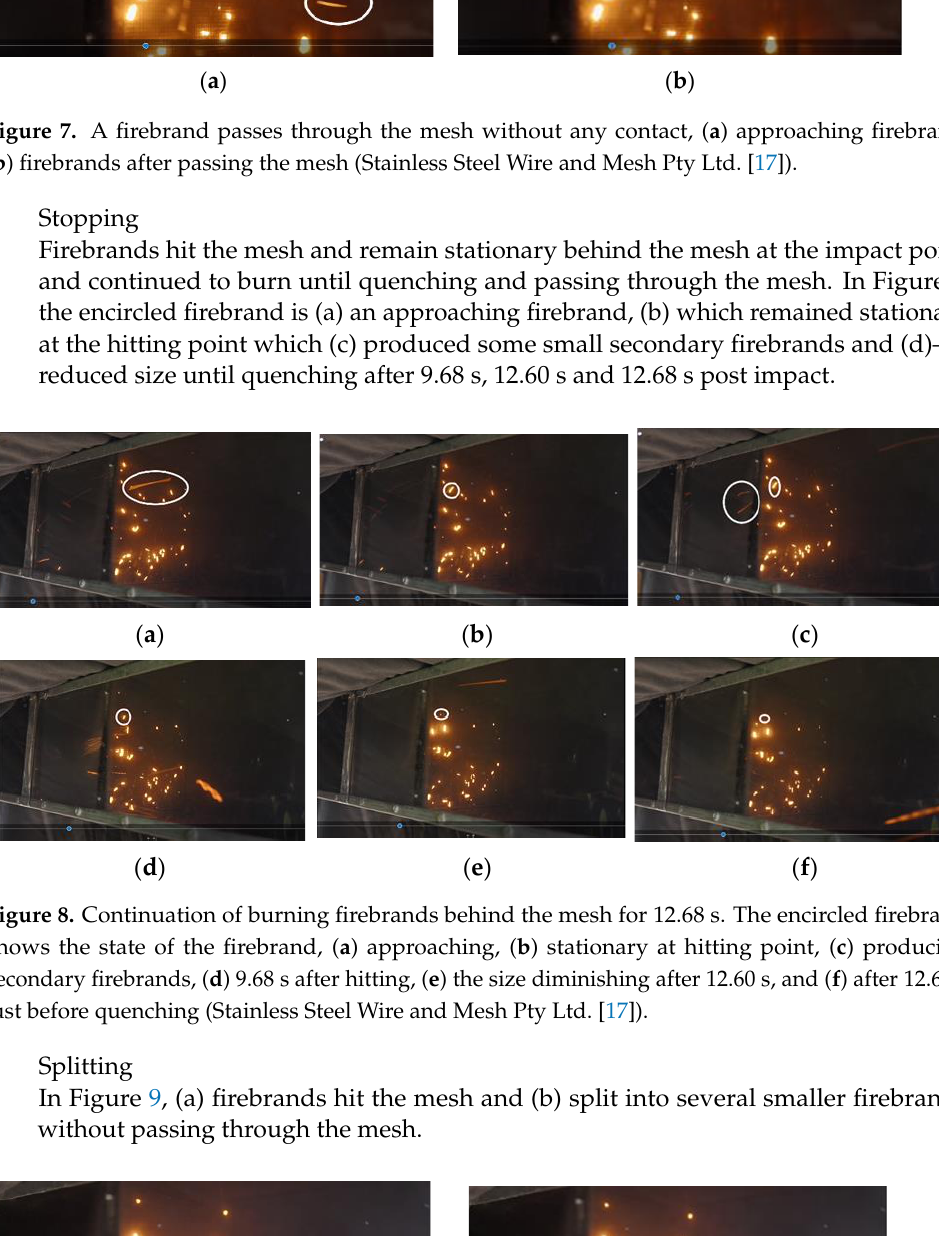
shows the state of the firebrand, ( a ) approaching, ( b ) stationary at hitting point, ( c )